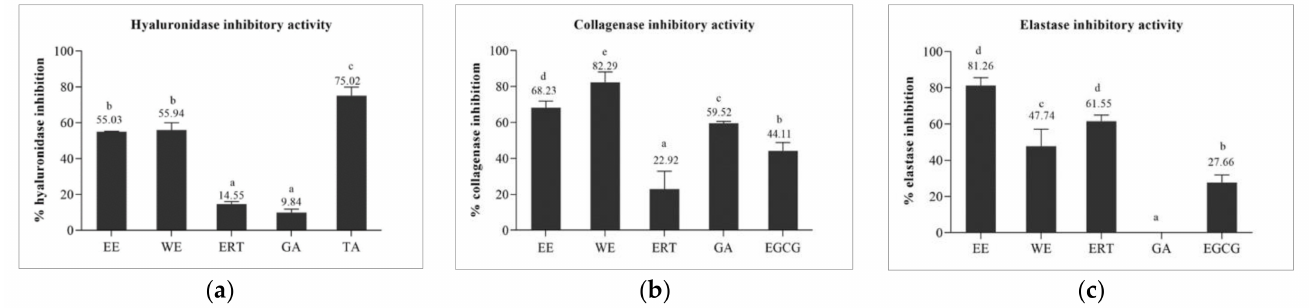
Figure 4. Inhibitory activities against ( a ) hyaluronidase, ( b ) collagenase, and ( c ) elastase of brown A. bisporus ethanol extract (EE), brown A. bisporus water extract (WE), ergothioneine (ERT), gallic acid (GA), tannic acid (TA), and epigallocatechin gallate (EGCG). Different letters above the bars indicate statistically significant differences. Different letters within columns indicate statistically significant differences ( p <